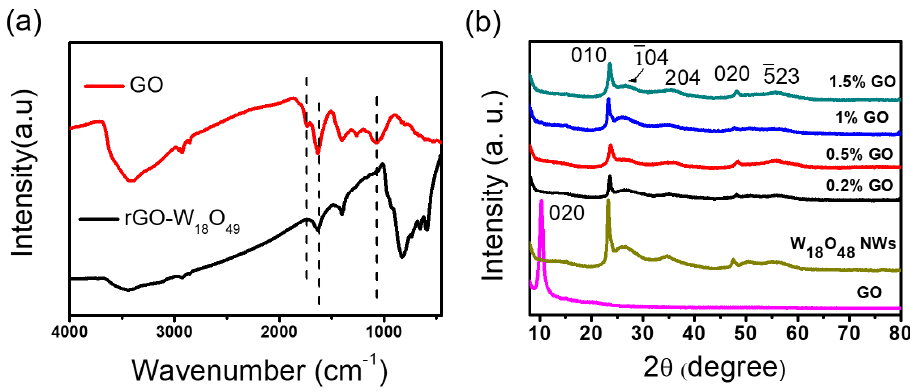
Figure 2. ( a ) FT-IR spectra of GO and 0.5 wt. % W 18 O 49 NWs/rGO composite ( b ) XRD spectra of the GO, W 18 O 49 NWs, and W 18 O 49 NWs/rGO composites with different amount of rGO contents.